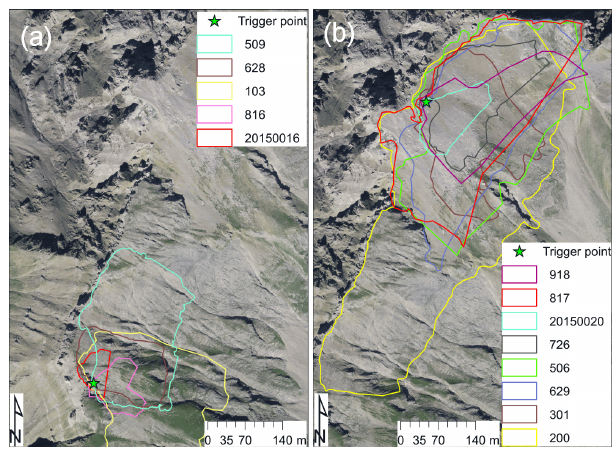
Figure 5. Extent of all selected release areas in (a) the southwestern part of CB1 and (b) CB2.